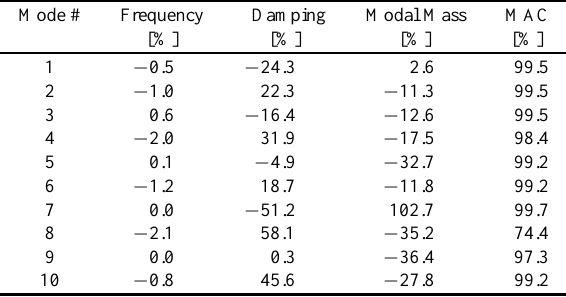
Table 2 Deviations of identified modal parameters with conventional